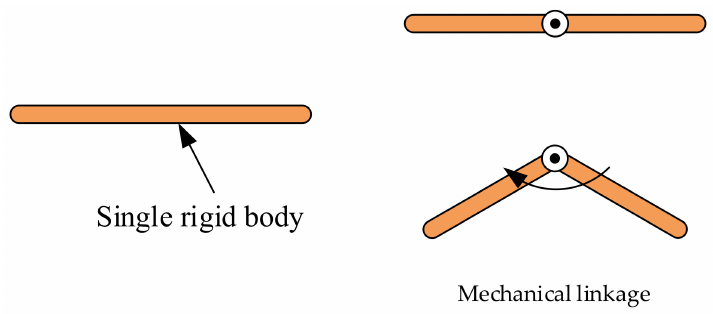
Figure 1. Example of a single rigid body and a mechanical